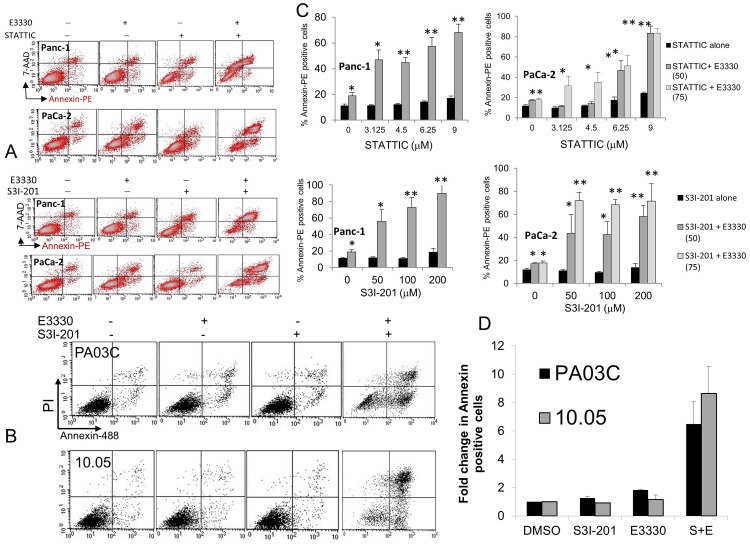
Effect on apoptosis of inhibition of APE1 in combination with STAT3 inhibitors in Panc-1, PaCa-2, and the patient-derived Pa03C and Panc10.05 cells.Inhibitors were added simultaneously (E3330 40, 50, or 75 µM), and apoptosis was determined using Annexin-V (x-axis) and 7-AAD or PI (y-axis) staining after 24 hr. Representative dot plots are shown in A and B with high dose of STAT3 inhibitor for Panc-1 and PaCa-2 and 50µMS3I-201 for the patient-derived cells. Graphical representation represents >3 independent experiments; *, p<0.05, **, p<0.01 all compared to STAT3 inhibitor alone at corresponding dose (A, C) or 2 independent experiments for (B, D).